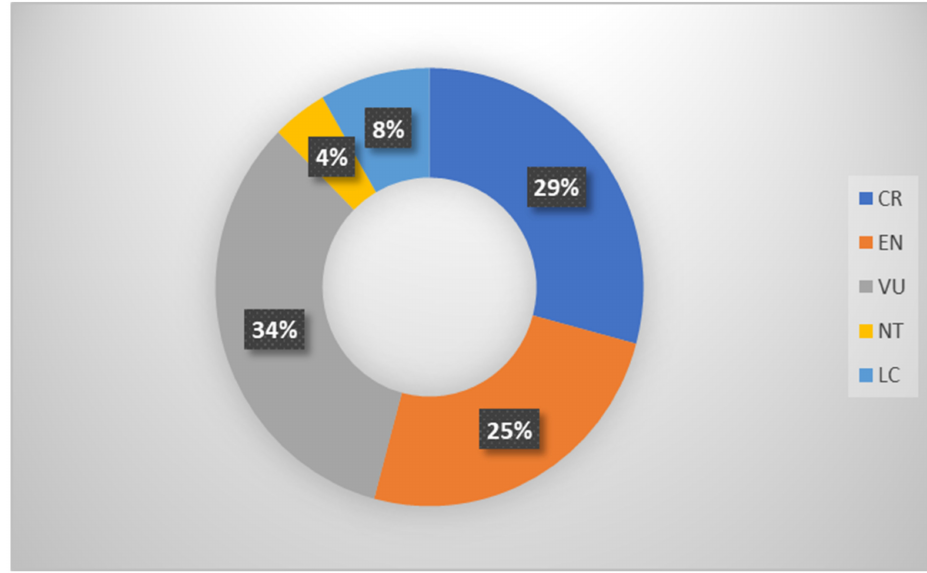
Figure 3. Chart of IUCN Red List status on